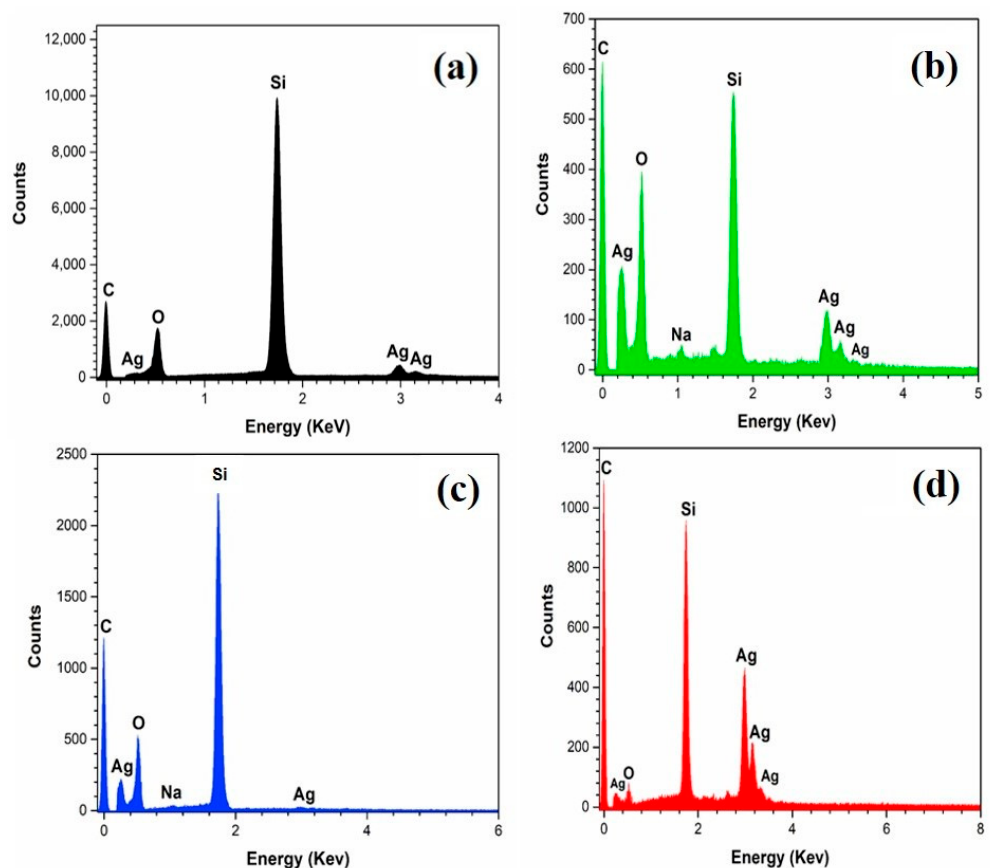
Figure 5. EDX spectra of G-SERS substrates. ( a ) Uncoated dendrites (N = 0). ( b ) GO-coated dendrites (N = 25). ( c ) rGO-coated dendrites (N = 5). ( d ) GNPs-coated dendrites (N = 1). N indicates the number of spray nozzle passes over the dendritic substrate.